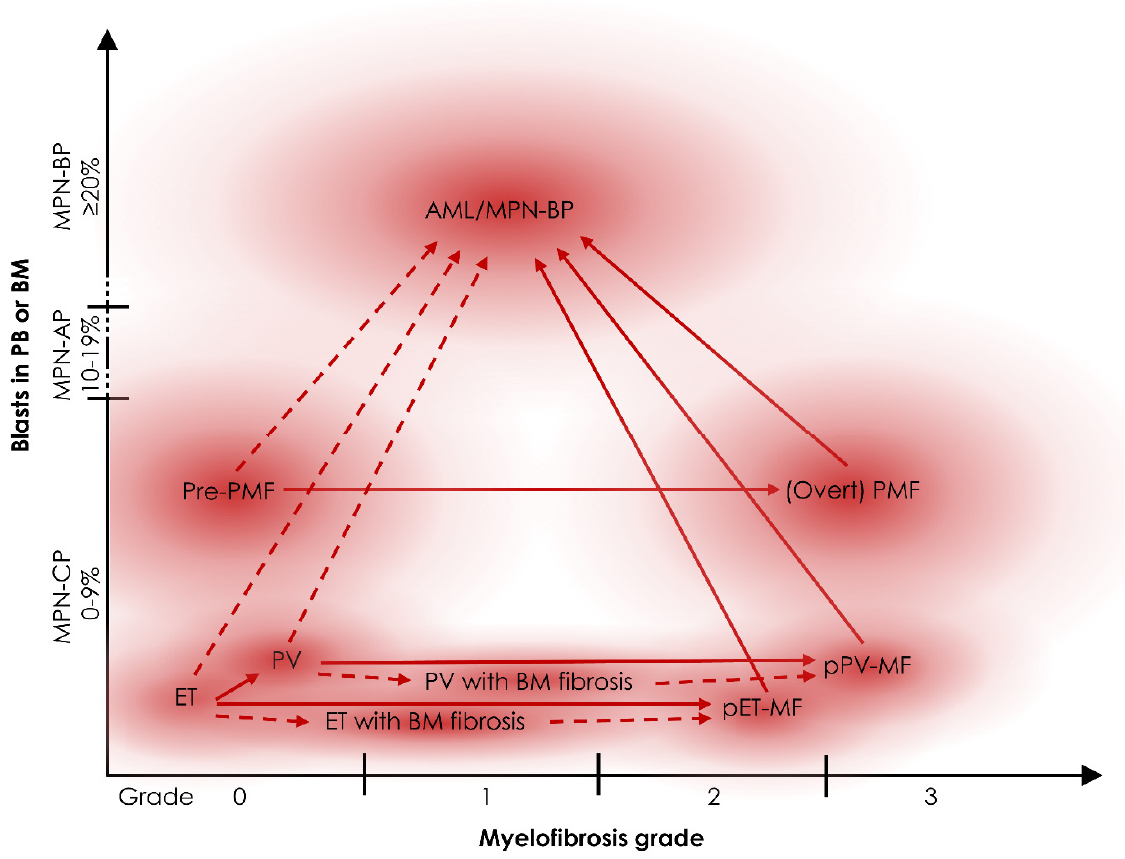
Figure 1. Types of MPN progression. Schematic representation of the different MPN subtypes arranged by the percentage of blasts ( y -axis) and myelofibrosis grade ( x -axis). The y -axis is subcategorized into chronic phase MPN (MPN-CP) with 0–9% blasts, accelerated phase (MPN-AP) with 10–19% blasts, and blast phase (MPN-BP) with ≥ 20% blasts in peripheral blood (PB) or bone marrow (BM). The types of progression are indicated in red arrows with dotted lines indicating less frequent types. AML, acute myeloid leukemia; ET, essential thrombocythemia; Pre-PMF, Prefibrotic primary myelofibro-